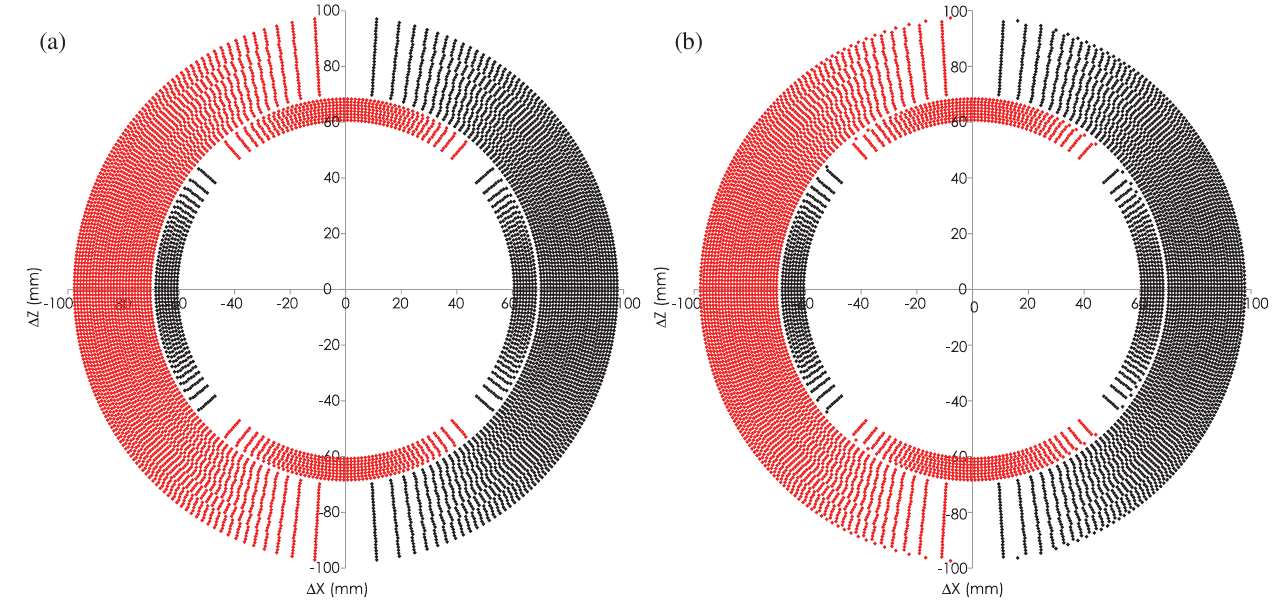
FIG. 7. Profile of the superconducting coil for the magnets of BM1-6 (a) before and (b) after a correction. The coil consisted of the 8 layers of the quadrupole coils and 26 layers of dipole coils. The dipole and quadrupole coils were electrically isolated, and can be independently excited.